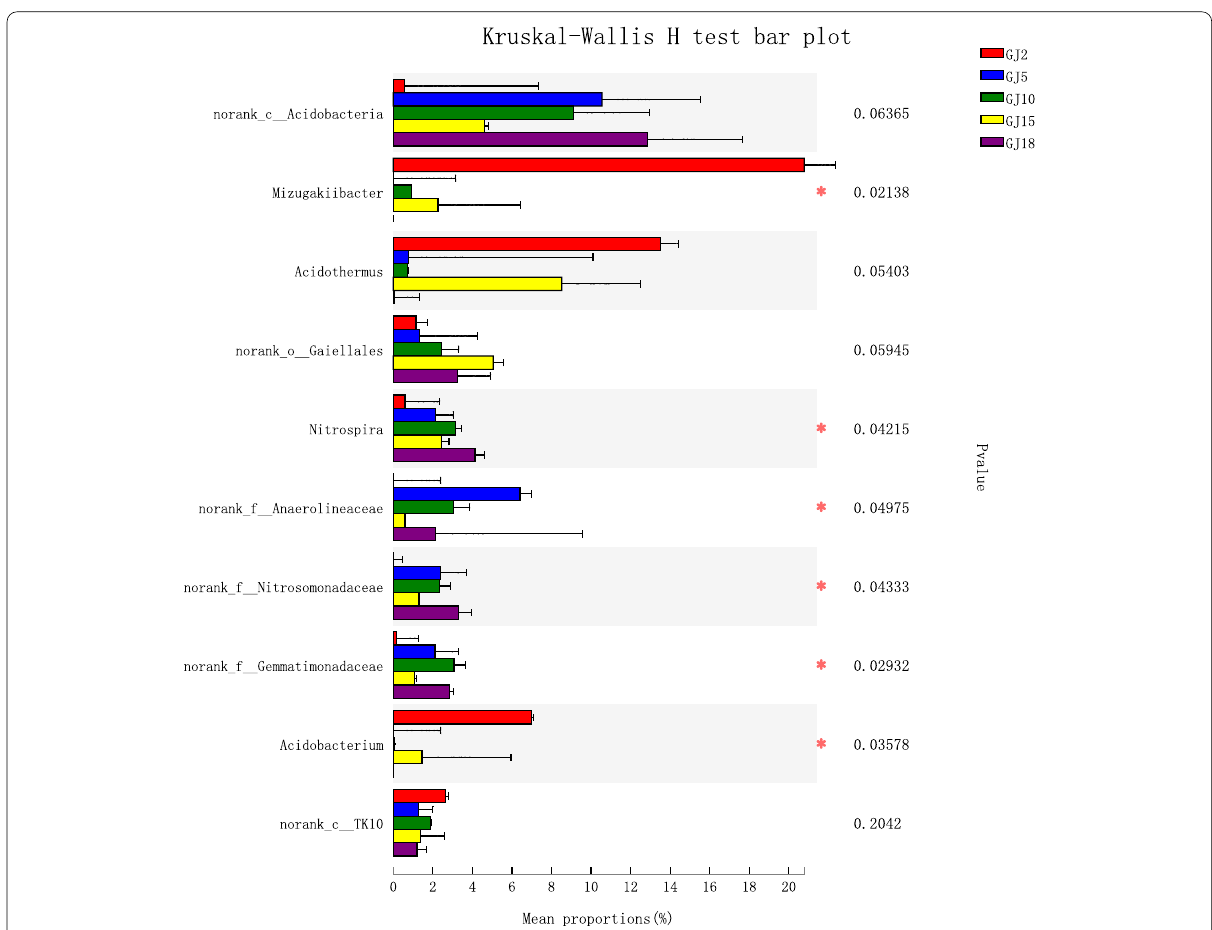
Fig. 6 Variation of soil bacterial community composition of the top 10 bacterial at genus level in citrus orchards with different ages. Date represent average of three replicates and error bars represent standard deviations. The right side is the p value,* indicate P